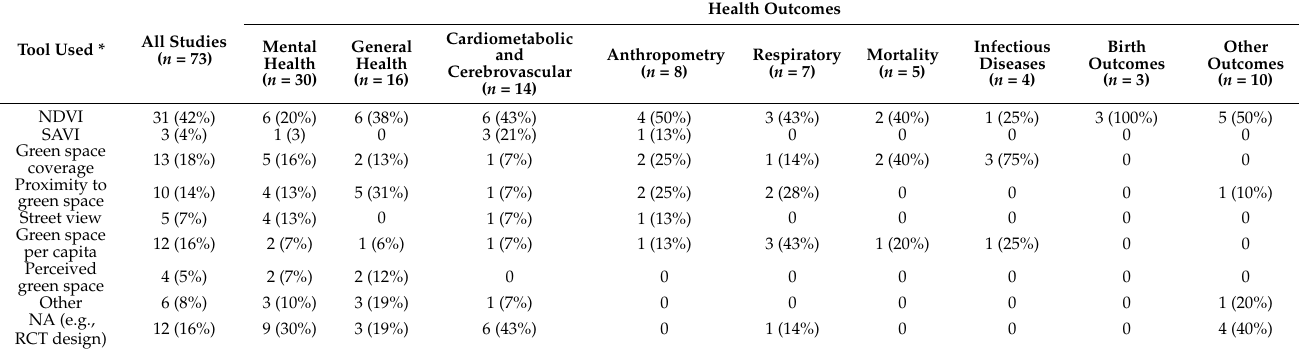
Table 2. Tools used for green space exposure measurements for each health outcome